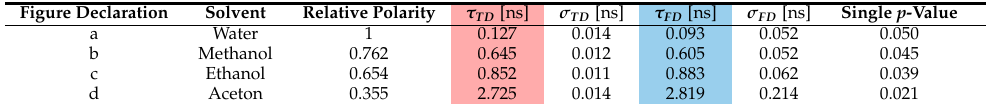
Table 4. Calculated p -values, detected lifetimes and relative polarity values for different solvents. Figure Declaration